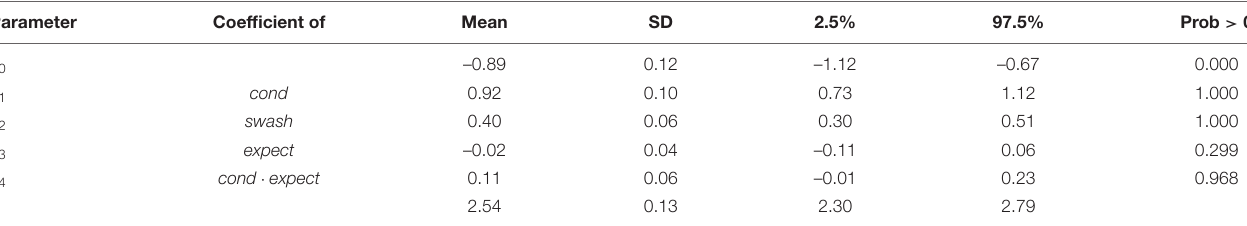
Prob > 0 contains the posterior probabilities of the parameter being